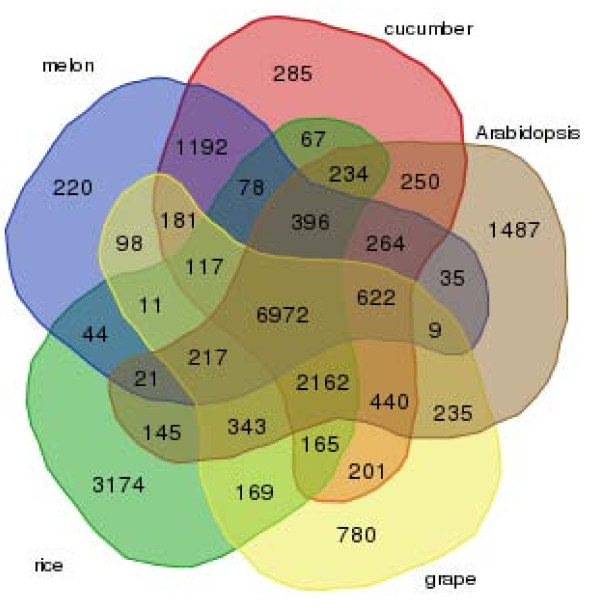
Venn diagram of ortholog group distribution in melon, cucumber, Arabidopsis, grape, and rice. Numbers in individual sections indicate the numbers of ortholog groups